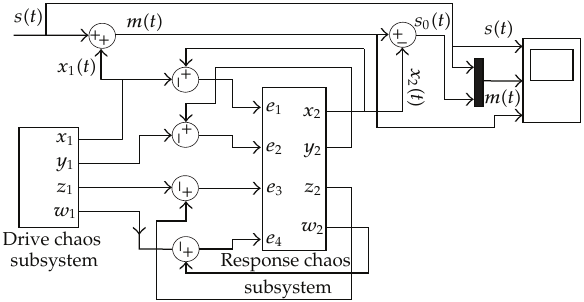
Figure 4: Chaotic masking technology for communication